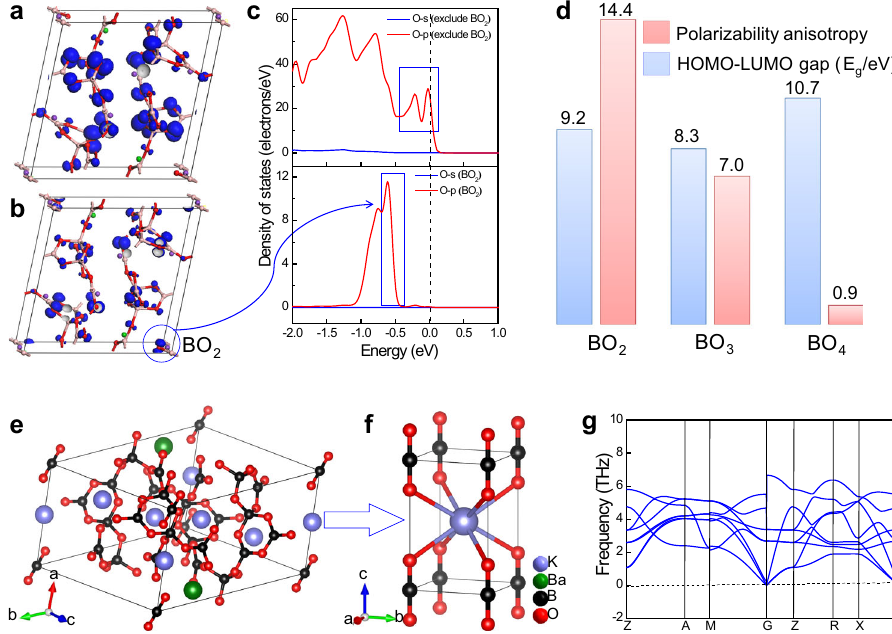
Fig. 3 The structure-property relationships of K 5 Ba 2 (B 10 O 17 ) 2 (BO 2 ). a – c The structure-property relationships of K 5 Ba 2 (B 10 O 17 ) 2 (BO 2 ). Frontier orbitals (isosurface) and partial density of states of O in K 5 Ba 2 (B 10 O 17 ) 2 (BO 2 ). d Calculated HOMO – LUMO gap (E g ) and polarizability anisotropy of B(11)O 2 , B(1) O 3 , and B(3)O 4 units in K 5 Ba 2 (B 10 O 17 ) 2 (BO 2 ). The polarizability anisotropy of BO 2 units is even larger than those of BO 3 and BO 4 units. Thus, larger birefringence, as determined by polarizability anisotropy, can be expected in BO 2 -containing borates. e , f Theoretical structural model of K(BO 2 ) with solely BO 2 units derived from K 5 Ba 2 (B 10 O 17 ) 2 (BO 2 ). g The phonon dispersion of K(BO 2 ). There are no soft modes at any wave vectors and none of the imaginary phonon modes are observed, demonstrating that K(BO 2 ) is dynamically